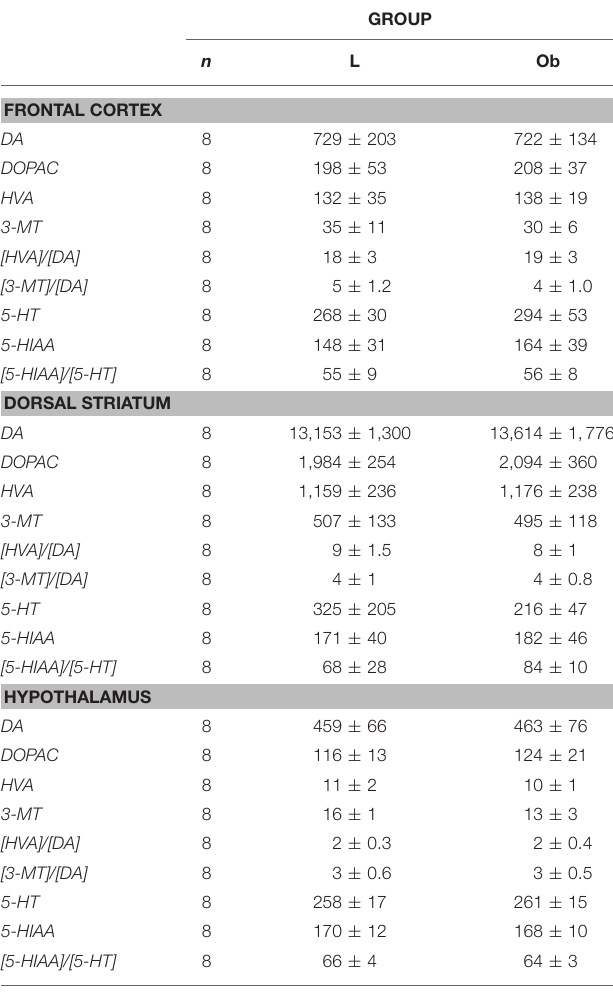
TABLE 3 | Brain concentration of monoamines (DA and 5-HT), their metabolites and the rate of metabolism investigated in FRONTAL CORTEX, DORSAL STRIATUM, and HYPOTHALAMUS in L, lean intact and Ob, obese intact